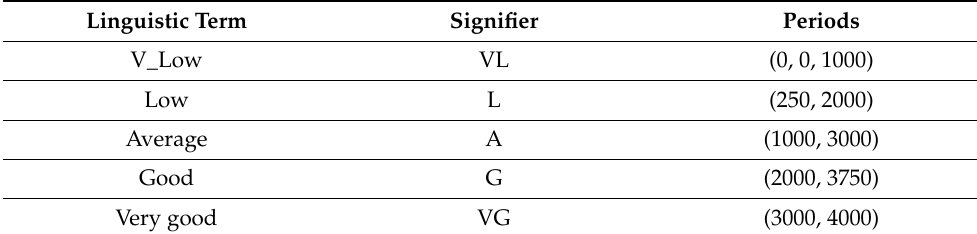
Table 5. Fuzzy set of input amount of attendance.